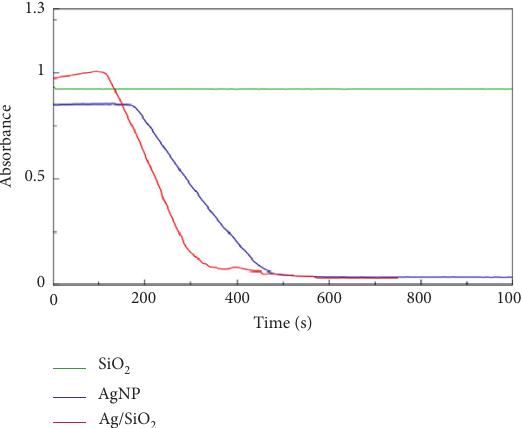
Figure 8: Reaction kinetics with different catalysts monitored by the absorbance at 400nm of the